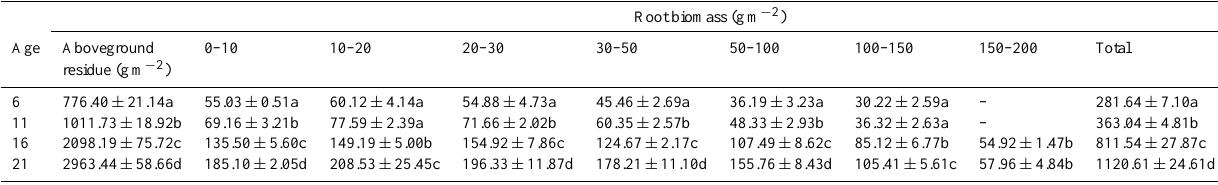
Table 2. Aboveground and root biomass in different stand ages of S. cheilophila